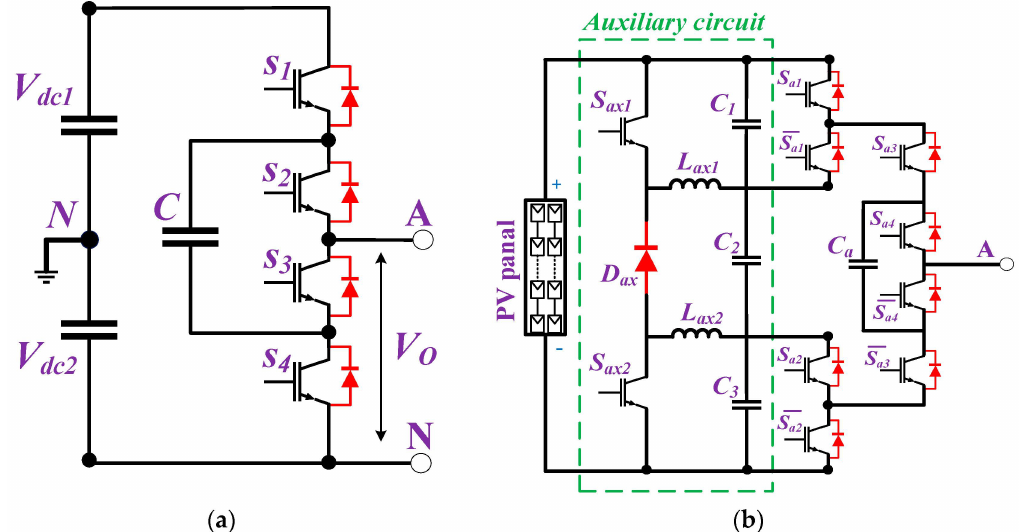
Figure 4. The single-phase circuit of FC topology; ( a ) a three-level NPC [42]; ( b ) a six-level hybrid FC with auxiliary circuit